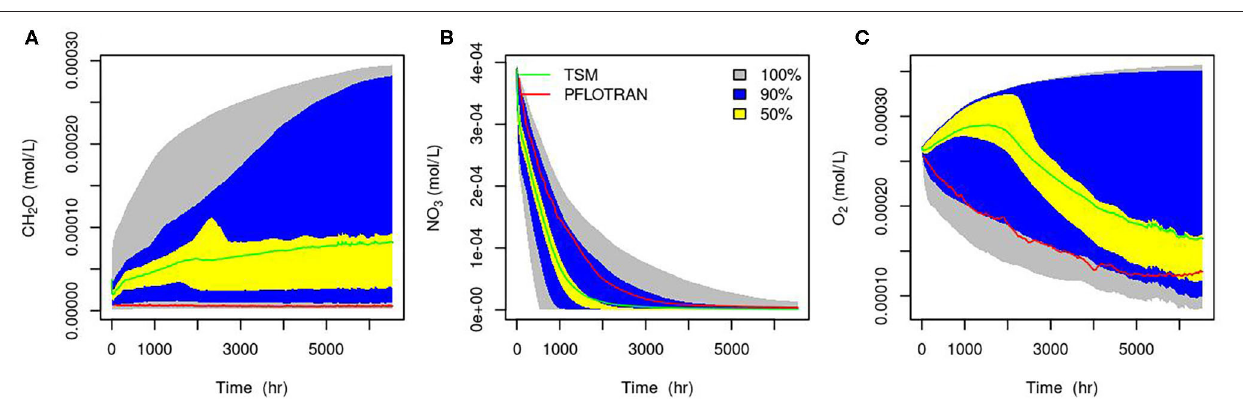
NO 3 and O 2 , respectively. The biomass decay rate constant is important for all three reactive components. The maximum rate constant for O 2 reduction ( k O 2 ) are of equal importance for O 2 and CH 2